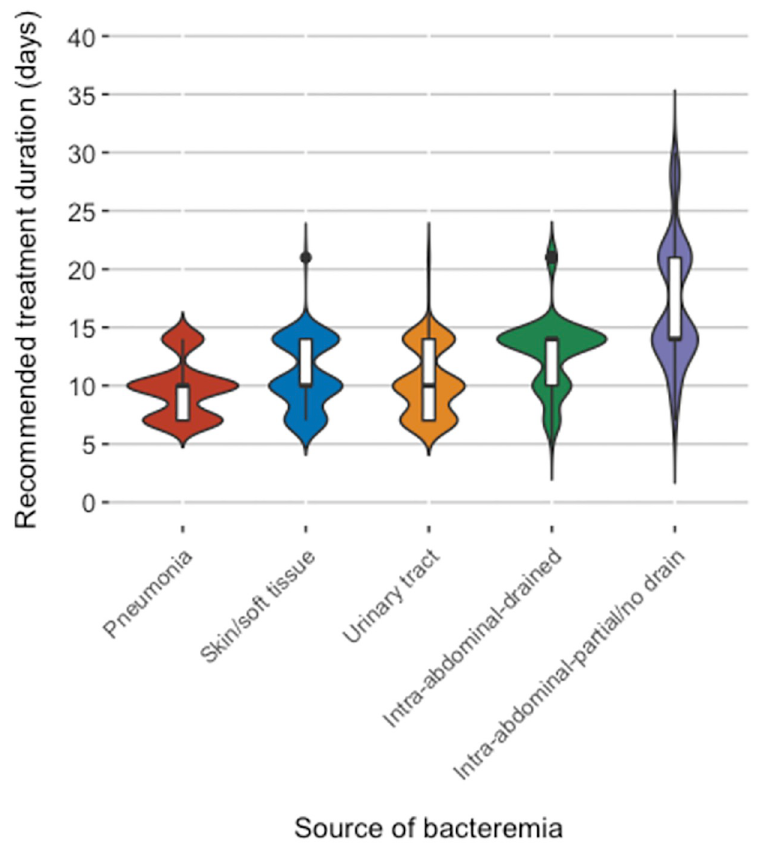
Fig 1. Violin plot distribution of recommended treatment durations for bacteremia from different sources. The shaded area represents the density of responses for treatment duration. Inside each violin, the thick line marks the median, the boxes indicate the interquartile range (IQR) and the lines mark 1.5xIQR for the treatment duration recommendation.